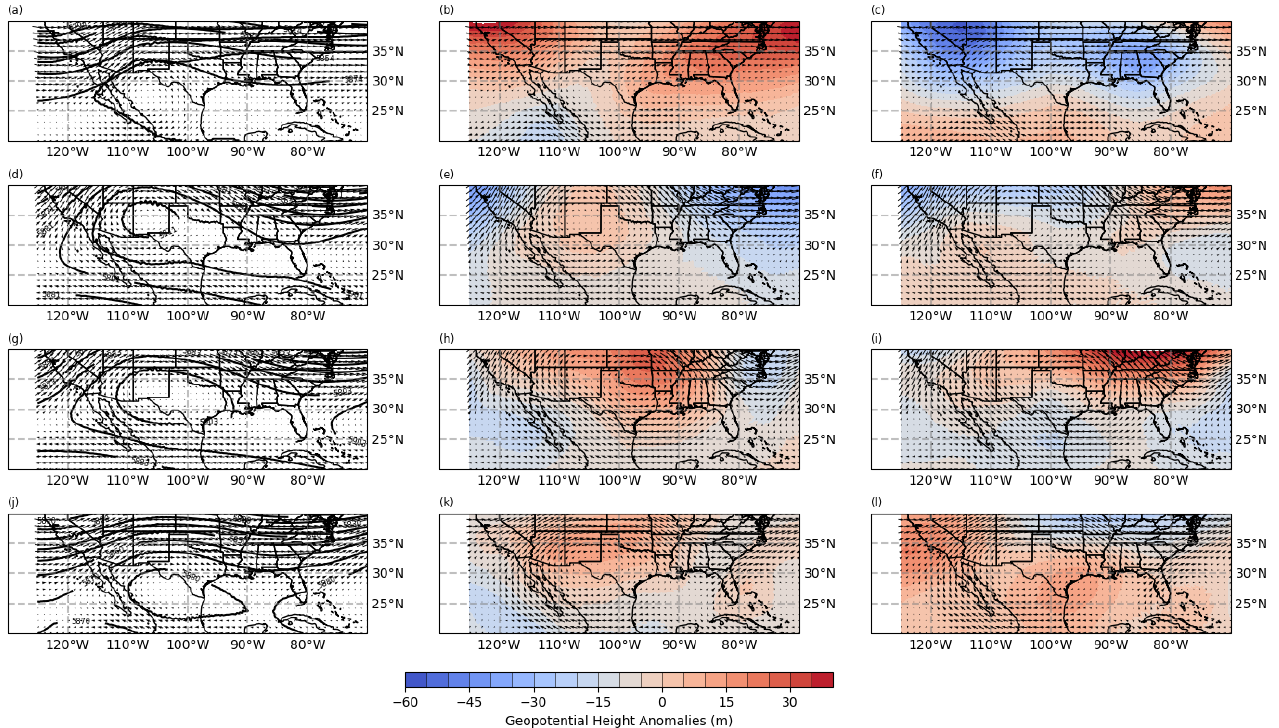
Figure 13. Synoptic conditions of period study ( a , d , g , j ), and anomalies of two active (less active) years b , e , h , k ( c , f , i , l ) for June ( a – c ), July ( d – f ), August ( g – i ), and September ( j – l ) months. Vectors are winds (m/s) and shaded areas are geopotential height anomalies